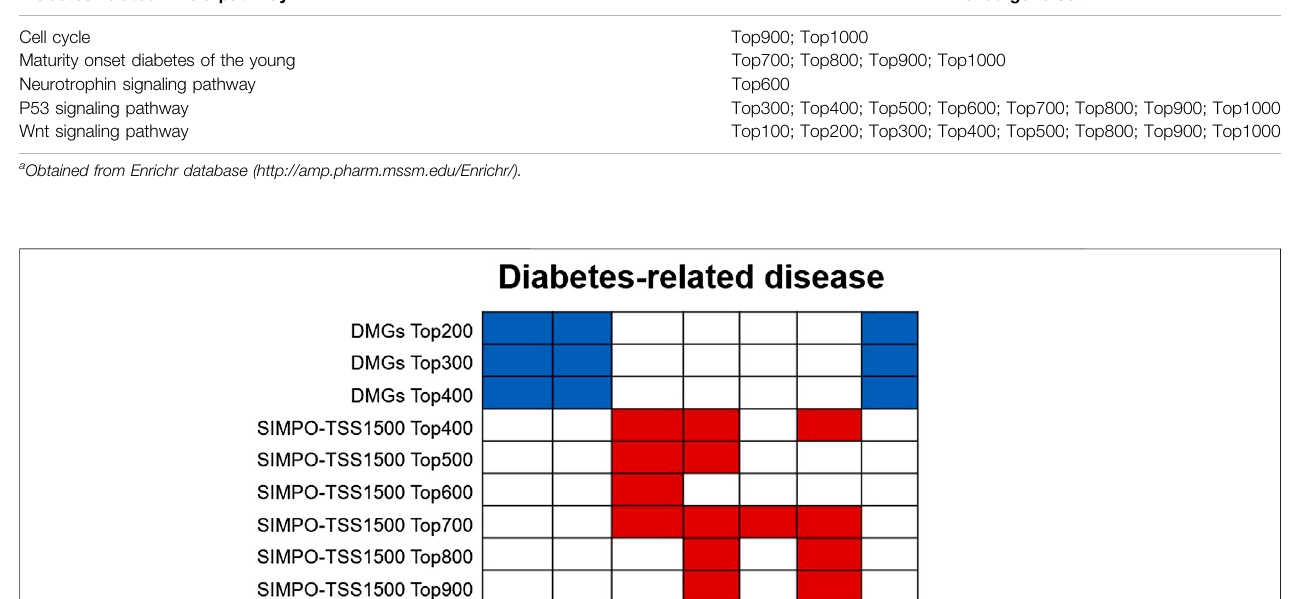
Frontiers in Molecular Biosciences |